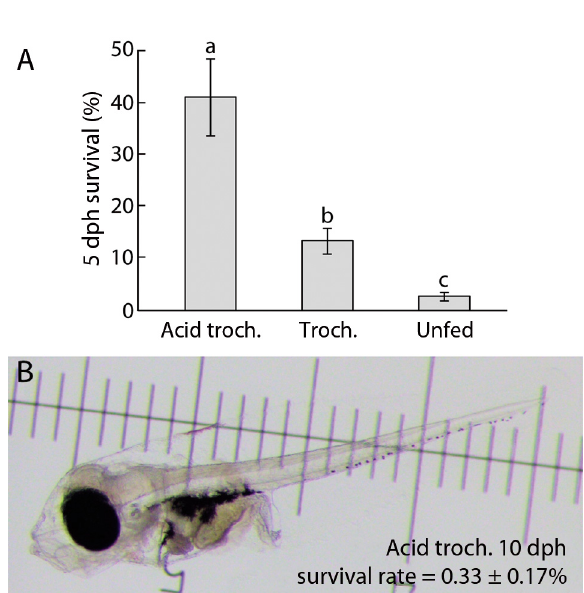
Fig. 8. Effect of diet on survival of Paracanthurus hepatus at (A) 5 d post-hatch (dph), and (B) image of 10 dph P. hepatus with corresponding survival rate. Diets: oyster trochophores exposed to pH 4.8 seawater (Acid troch.), regular oyster trocho phores (Troch.), and unfed. Data are means ± SE, n = 6. Bars with the same letters are not significantly differ- ent according to 1-way ANOVA followed by Tukey’s HSD test (p <